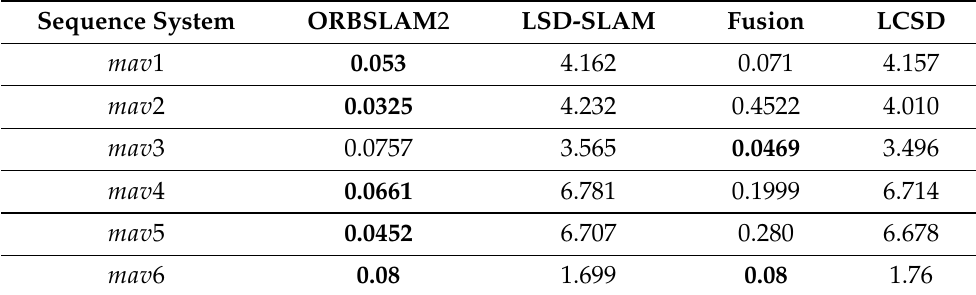
Table 3. RMSE of the four systems on sequences of the EuRoC database (best results in bold). The values represent the mean over five passes of each